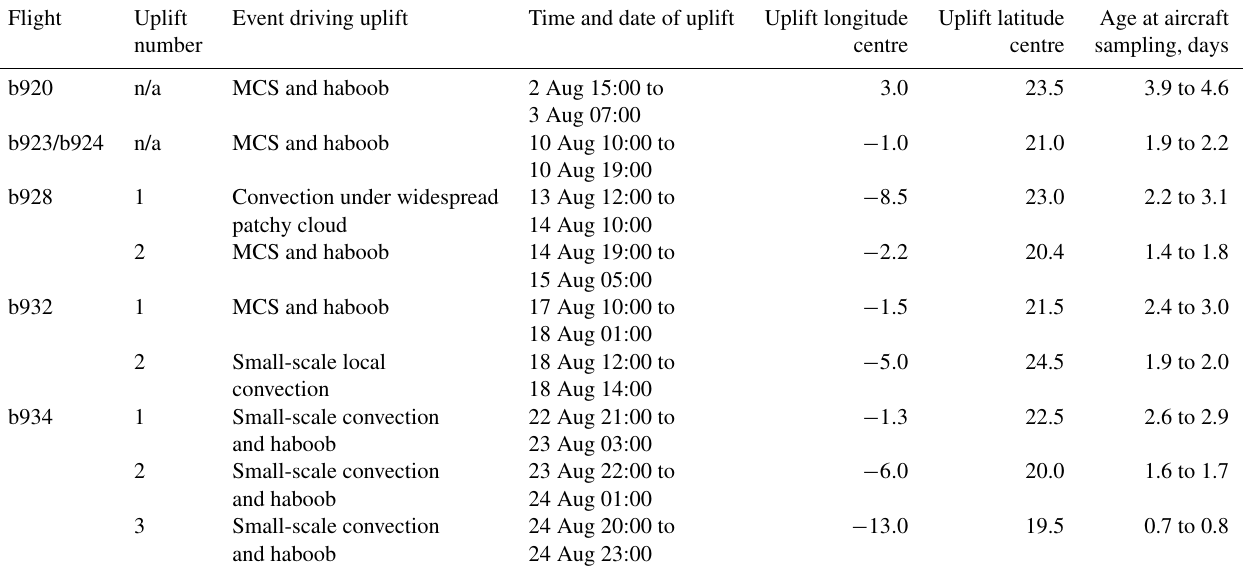
Table 4. Details of dust uplift events determined from SEVIRI RGB imagery driving dust sampled by the aircraft. Uplift numbers correspond to primary, secondary or tertiary uplift, also indicated in Fig. 1. Flight Uplift Event driving uplift Time and date of uplift Uplift longitude Uplift latitude Age at aircraft